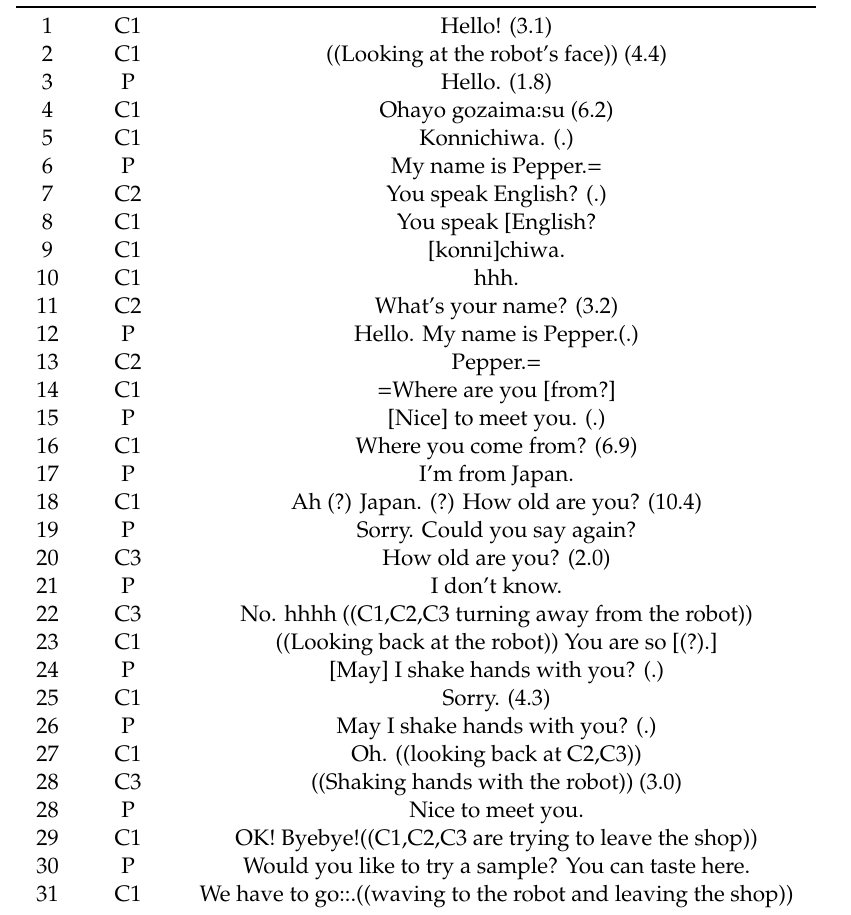
Table 13. Conversation in which it took a long time to select a button without the state-transition model (17 April